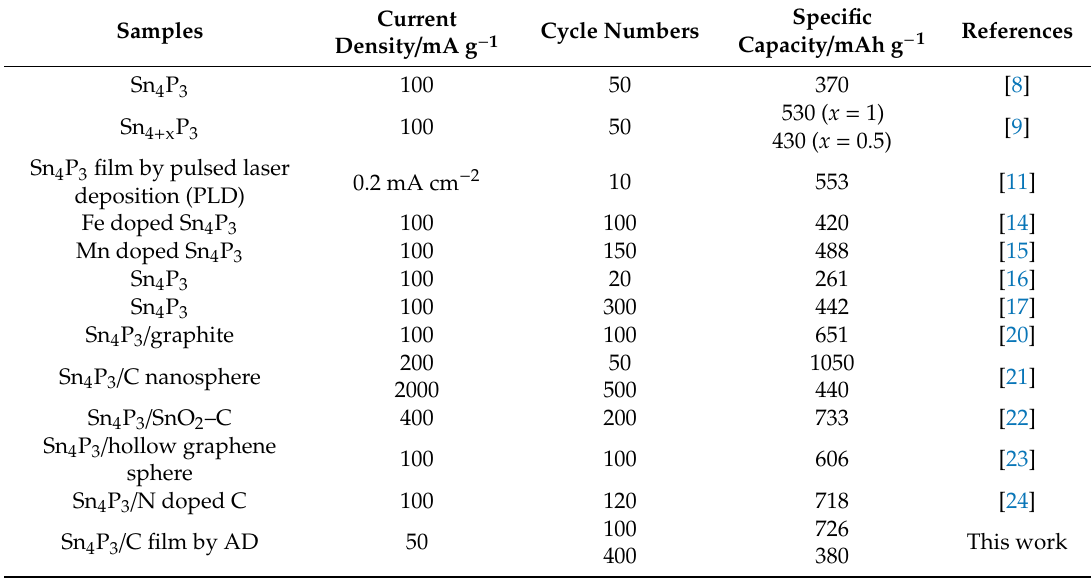
Table 1. Comparison of electrochemical performance of some Sn 4 P 3 anode materials for Li-ion batteries (LiB). AD: aerosol deposition.